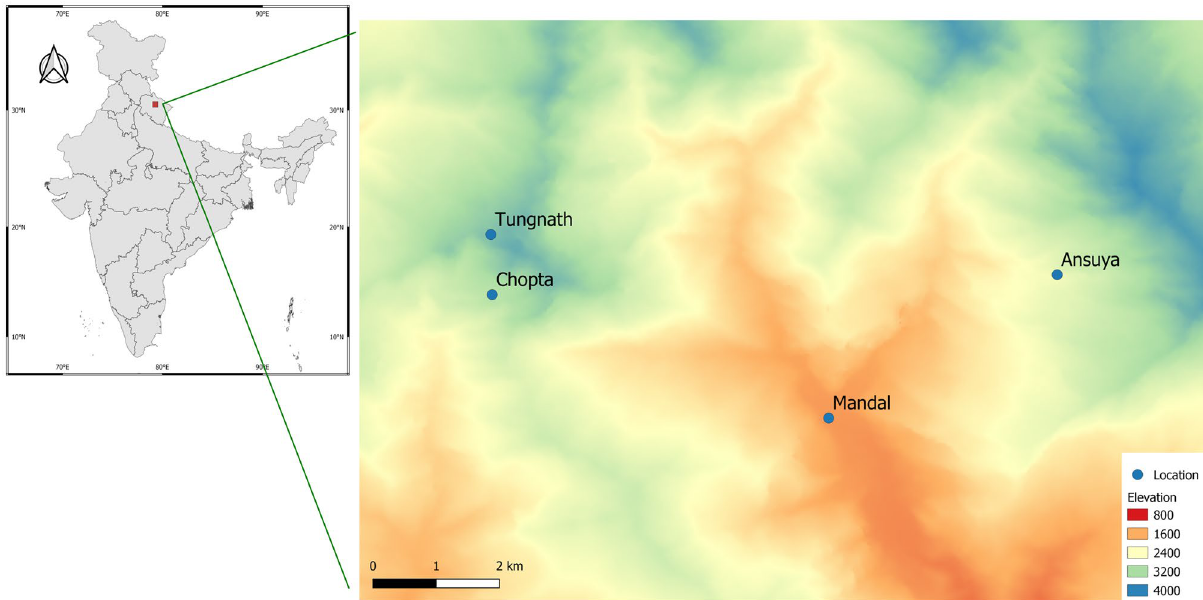
Figure 1. Map of India showing the location of the study area, Kedarnath Wildlife Sanctuary, and the sampling locations within the study area. Elevation is in m asl. The map was created using QGIS (v 3.6.3-Noosa) (QGIS Geographical Information System, www. qgis. org). Please note that the geographical boundaries represented in the map may contain areas considered